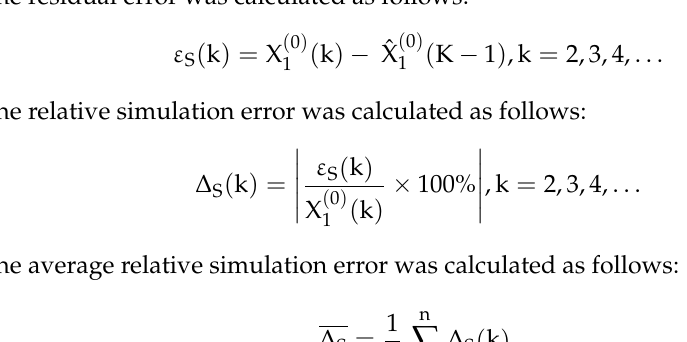
Table 5. Error of absolute dry flexural strength simulation results. Modeling Serial Num-